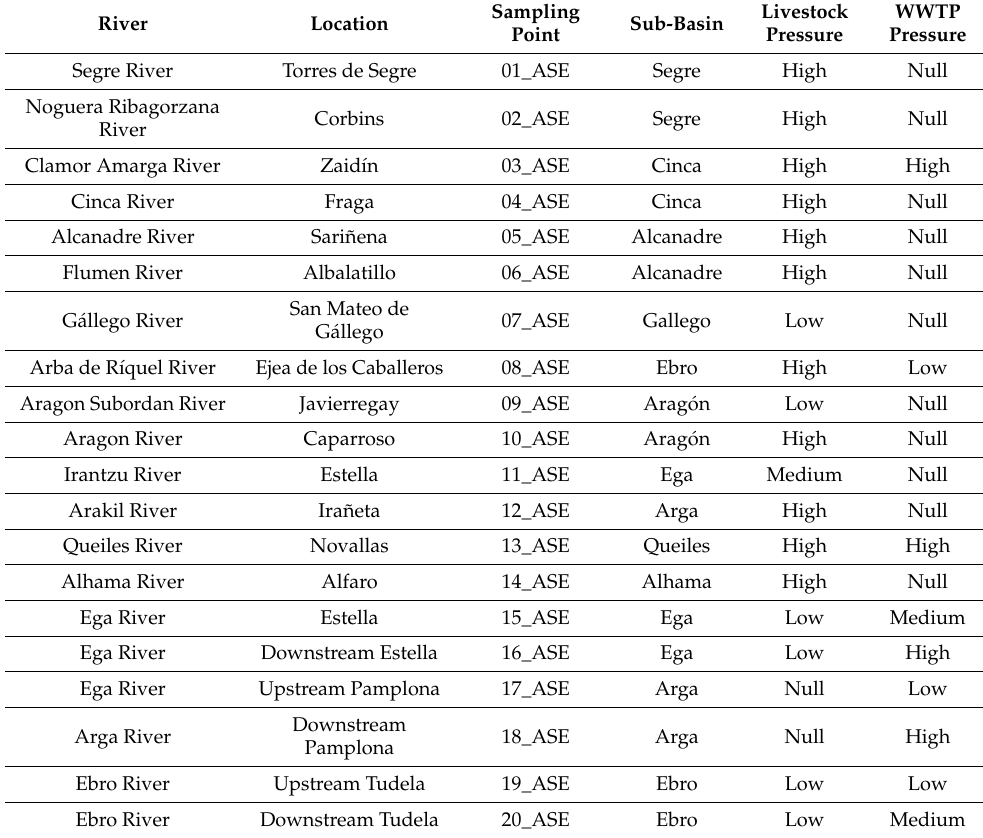
Figure 1. Surface-water-sampling points in the Ebro River basin (North of Spain). Table 1. List of surface-water-sampling points: locations and pressures